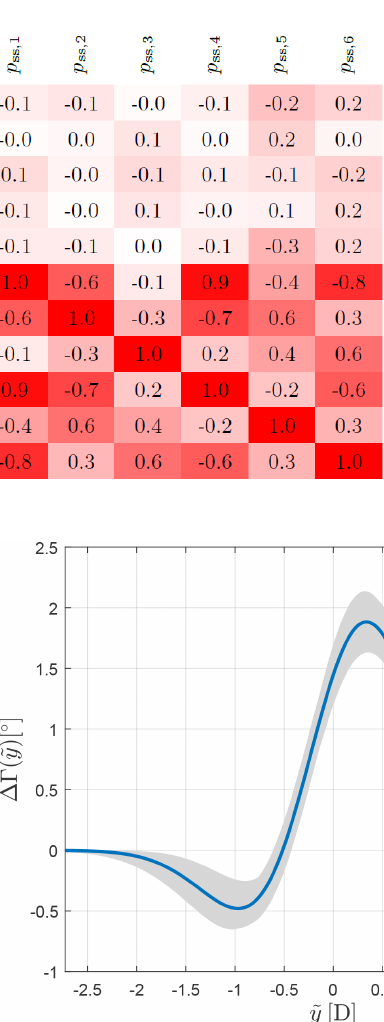
Figure 8. Identified wind direction change (cid:49)(cid:48) due to secondary steering as a function of distance ˜ y to the wake centerline for a turbine misalignment of 20 ◦ . The gray shaded area shows the un- certainty